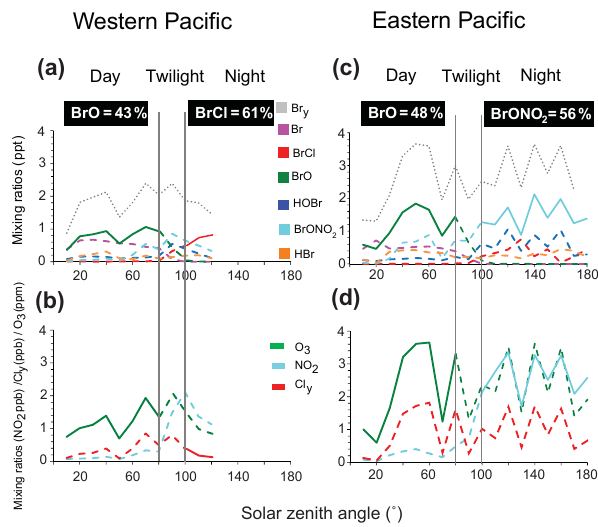
Figure 7. Average of inorganic bromine species (a, c) and main reactants of the inorganic chemistry (b, d) for all ATTREX flights developed over the western Pacific (a, b) and eastern Pacific (c, d) . The output from each flight has only been sampled between 14 and 18km and the average has been performed within ± 5 ◦ SZA bins. Black boxes indicate the percentage of the dominant Br y species for day and night at 17km.